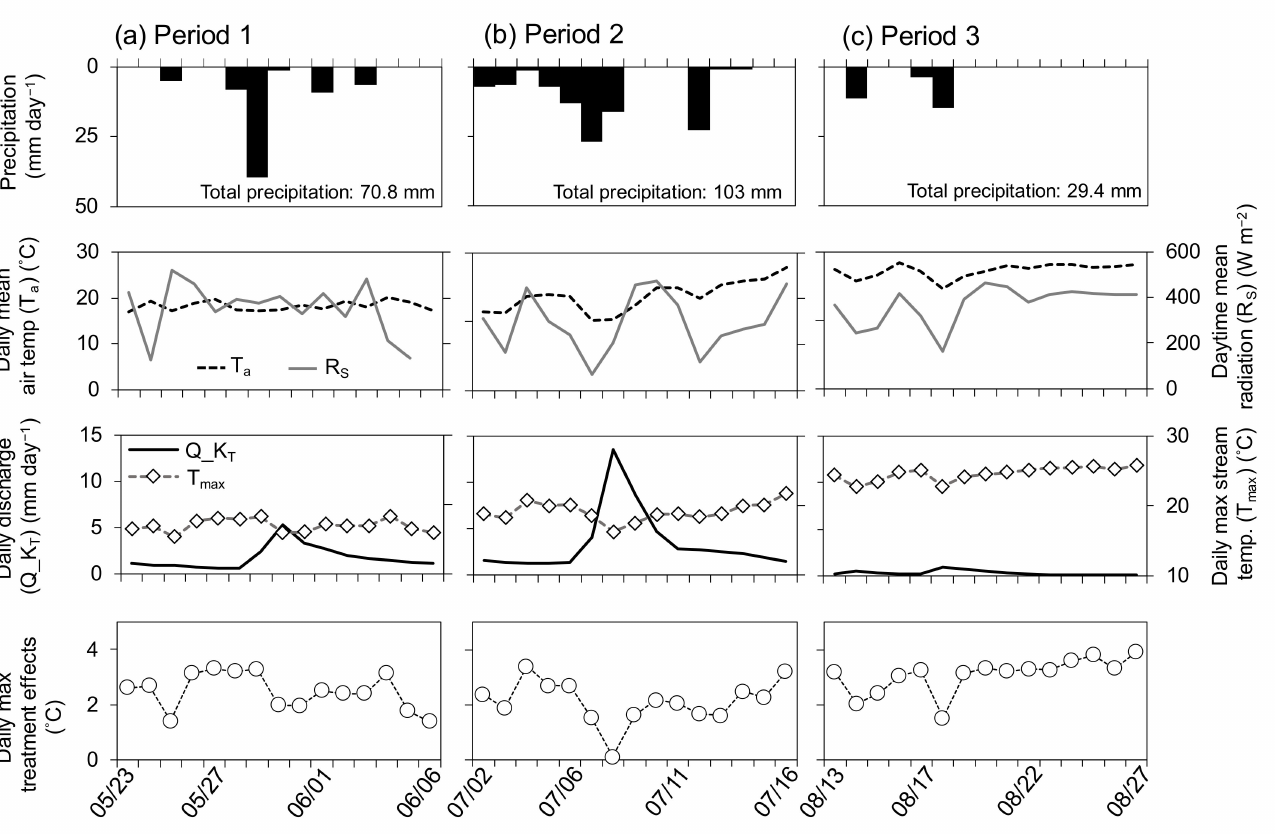
Figure 7. Changes in precipitation, runoff, climate condition, and treatment effect in selected periods of May ( a ), July ( b ), and August ( c ) in the post-thinning period. ( a ) Period 1 from 23 May to 6 June 2012 had less increase in discharge, ( b ) period 2 from 2 July to 16 July 2012, discharge increased significantly after storm events, and ( c ) period 3 from 13 August to 27 August 2012 had low rainfall and